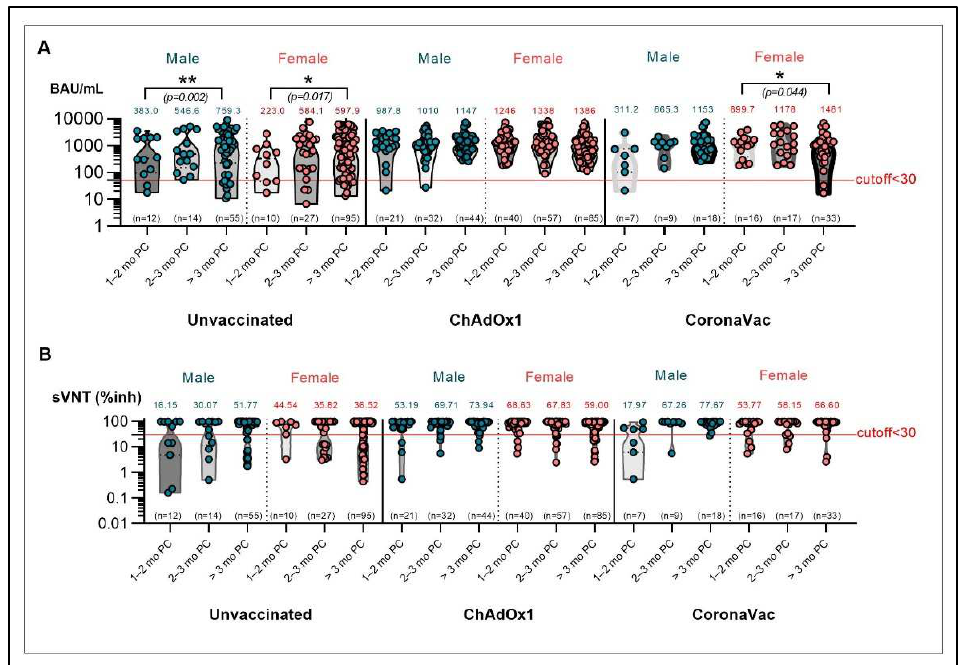
Figure 7. Immune responses after breakthrough COVID-19 infection with prior CoronaVac or ChAdOx1 vaccination during the Delta pandemic. Anti-RBD IgG concentrations ( A ), sVNT ( B ) by sex/vaccination/reinfection status. * p < 0.05; ** p < 0.01.